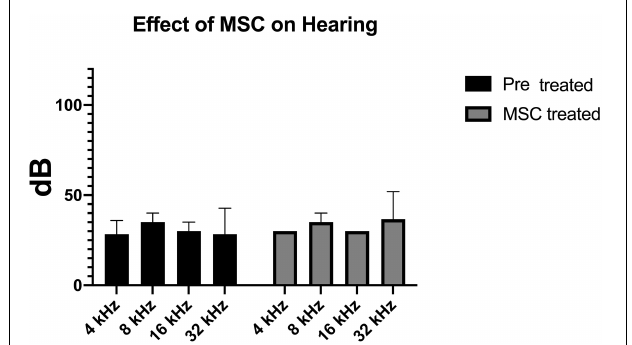
FIGURE 1 | Delivery of MSCs did not have any effect on baseline hearing. Hearing thresholds measured by ABR at four different frequencies prior to (black bars) and 7 days after transplantation of MSC to the inner ear via the posterior semicircular canal (gray bars) are depicted. There is no significant difference between the pre- and post-transplantation thresholds.